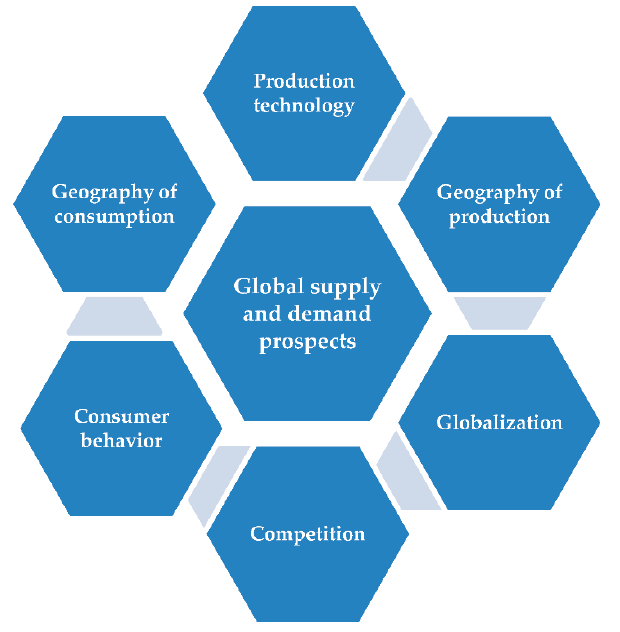
Figure 1. Main foresight factors in the Delphi study. Source: The authors.